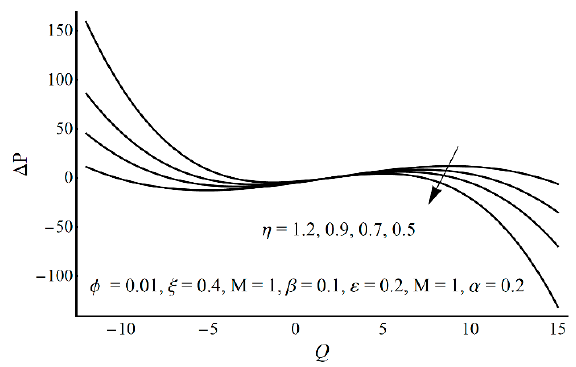
Figure 11. Pressure-rise per wavelength at various values of ξ .